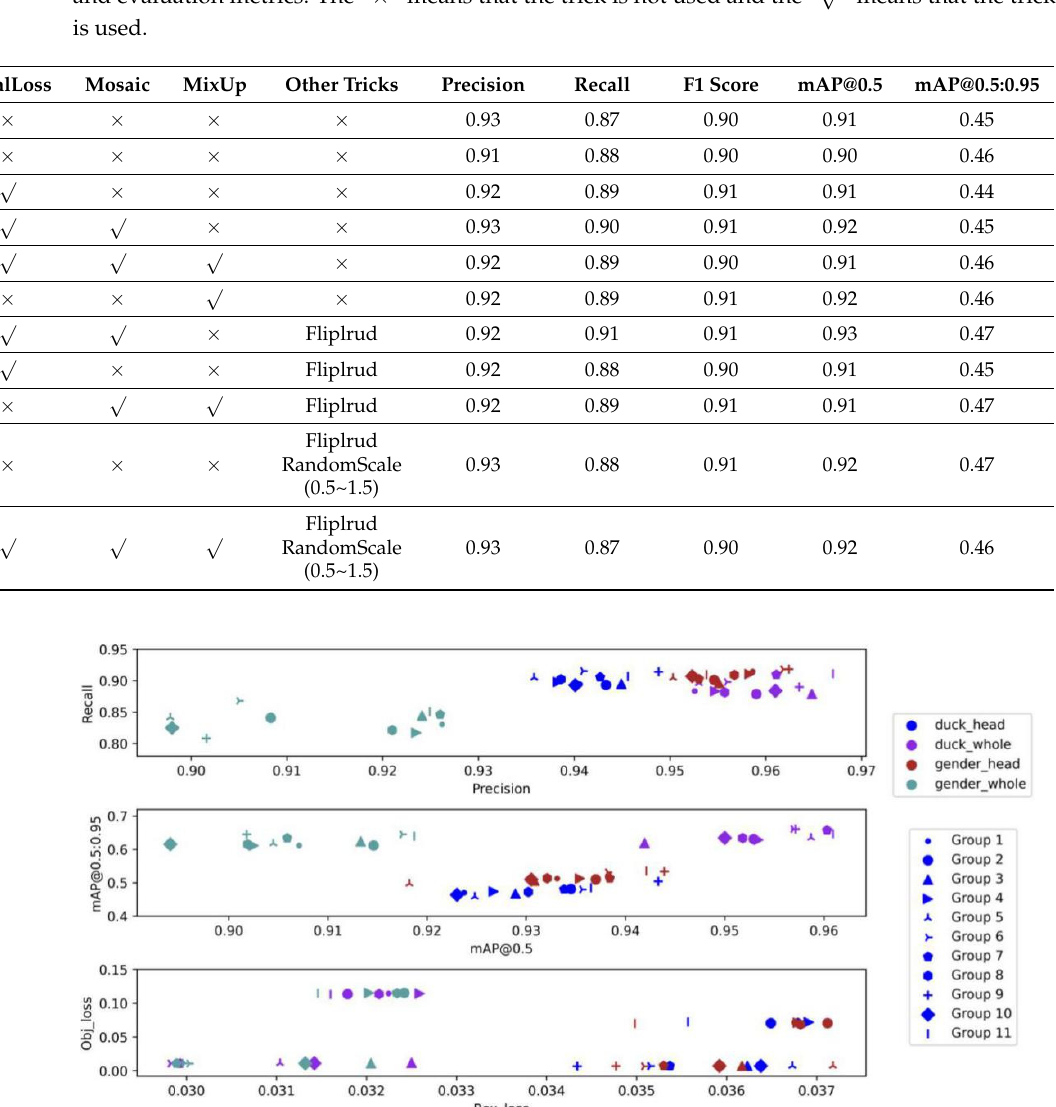
√ ” means that the trick